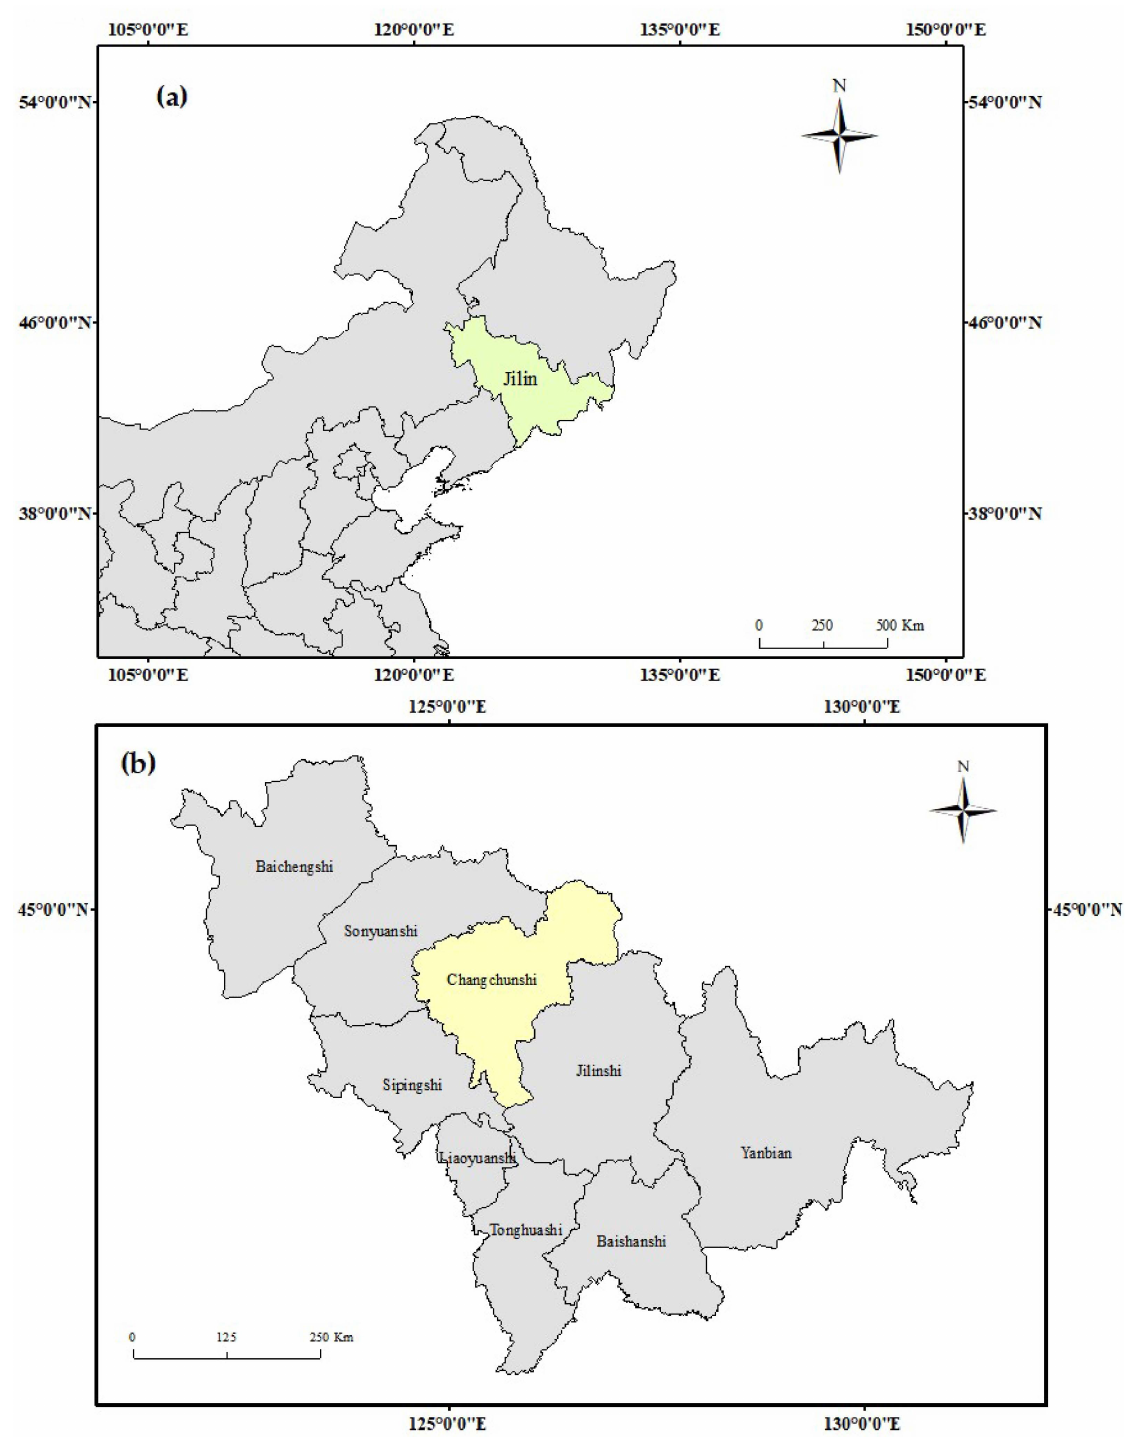
Figure 1. Location of the fire site: Jilin Province in China; disaster site of Changchun Prefecture in Jilin Province (from the ( a ) to the ( b